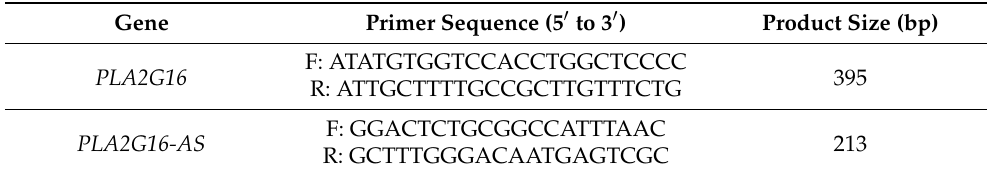
Table 1. Primer information for quantitative real-time PCR (qRT-PCR).